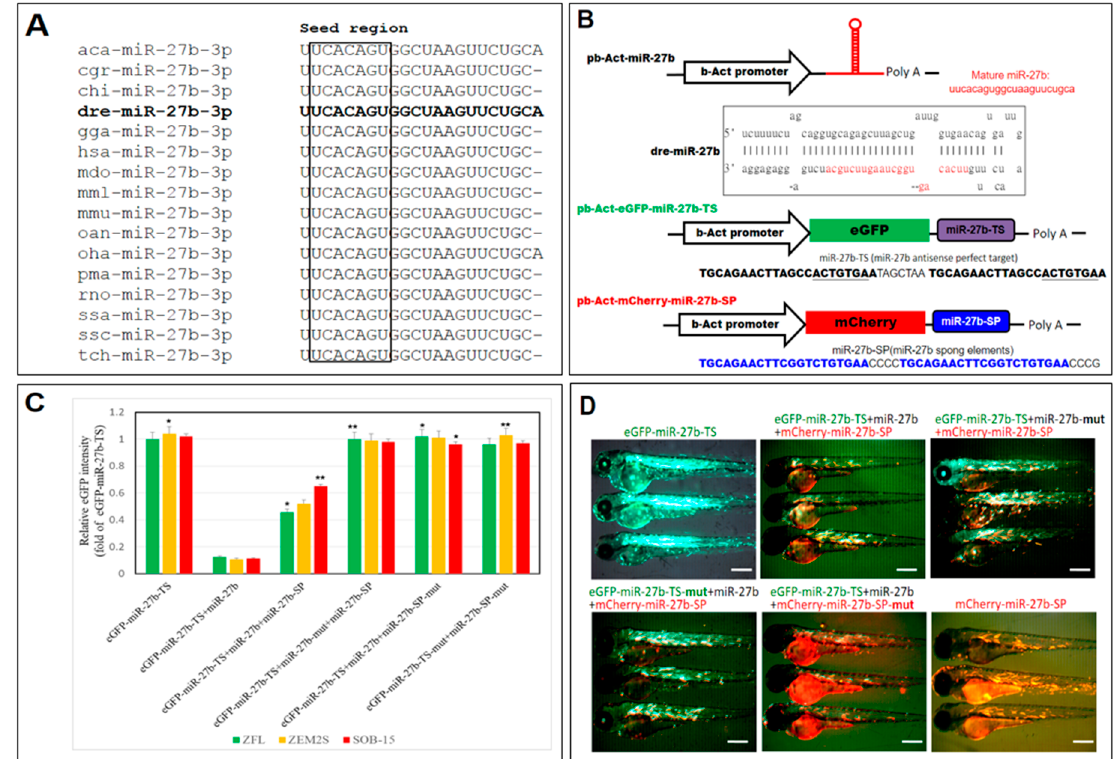
Figure 1. Design and validation of a miR-27b-sponge (miR27b-SP). ( A ) Alignment of the mature miR-27b sequence is perfectly conserved across many species, including arboreal lizard ( Anolis carolinensis ; aca-miR-27b), chinese hamster ( Cricetulus griseus ; cgr-miR-27b), domestic goat ( Capra hircus ; chi-miR-27b), zebrafish ( Danio rerio ; dre-miR-27b), red junglefowl ( Gallus gallus ; gga-miR-27b), humans ( Homo sapiens ; hsa-miR-27b), gray short-tailed opossum ( Monodelphis domestica ; mdo-miR-27b), rhesus macaque ( Macaca mulatta ; mml-miR-27b), mouse ( Mus musculus ; mmu-miR-27b), platypus ( Ornithorhynchus anatinus ; oan-miR-27b), king cobra ( Ophiophagus hannah ; oha-miR-27b), sea lamprey ( Petromyzon marinus ; pma-miR-27b), rat ( Rattus norvegicus ; rno-miR-27b), Atlantic salmon ( Salmo salar ; ssa-miR-27b), wild boar ( Sus scrofa ; ssc-miR-27b) and chinese tree shrew ( Tupaia chinensis ; tch-miR-27b). ( B ) Cloning of pri-miR-27b and miR27b-SP into b-Act expression vectors. Stem-loop structure of premiR-27b is shown, in which mature miR-27b is highlighted in red. ( C ) In vitro EGFP reporter assays were performed to confirm the direct interaction between miR-27b and the target sequences. ZFL, ZEM2S, and SOB-15 cells were transfected with indicated b-Act-miR-27b plasmids, and the EGFP intensity was measured. * p < 0.01, and ** p < 0.005. ( D ) In vivo EGFP reporter assays were performed to confirm the direct interaction between miR-27b and the target sequences in six days post fertilization (dpf) zebrafish larvae.